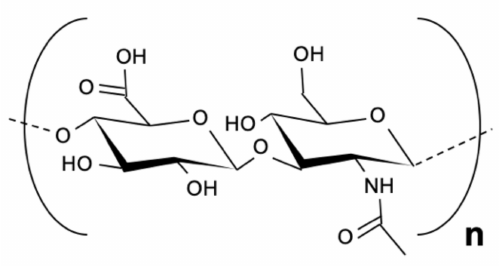
Figure 4. The skeletal structure of hyaluronic